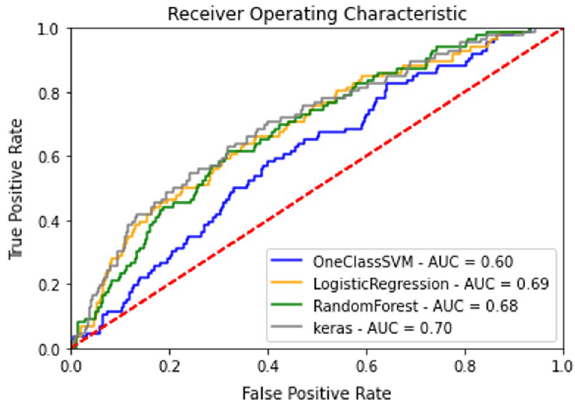
Fig. 2 ROC curves—model outputs from the test